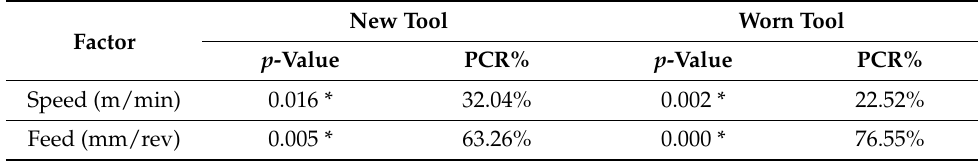
Table 6. Statistical significance of speed and feed on surface